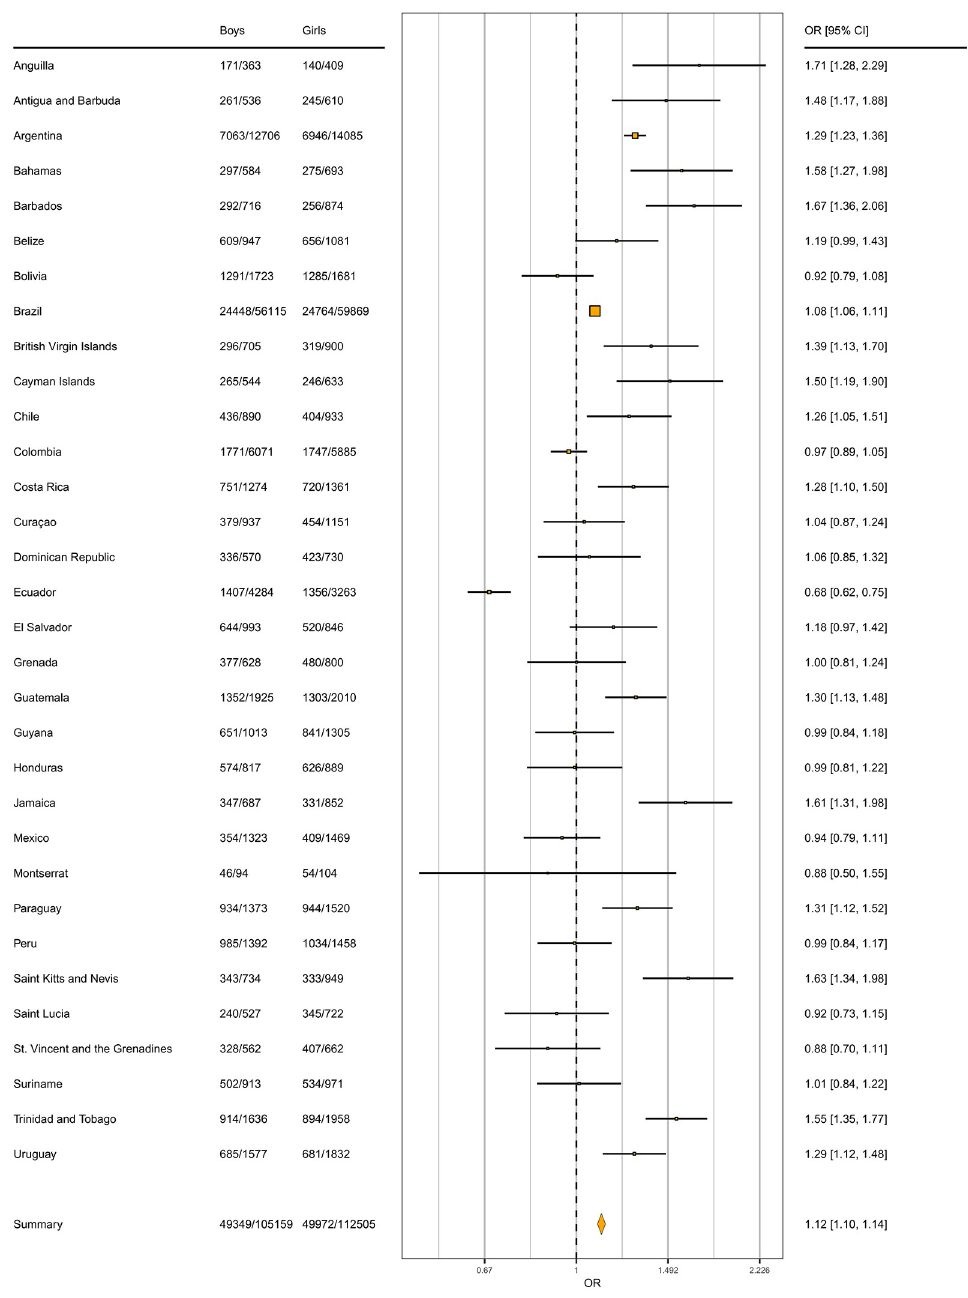
(n = 205) in comparison with the rest of analyzed countries. To the best of our knowledge, there is not a specific public policy promoting physical activity in Montserrat [31]. The small population and the higher proportion of women in Montserrat could potentially be responsi- ble for this result favorable to girls [32].